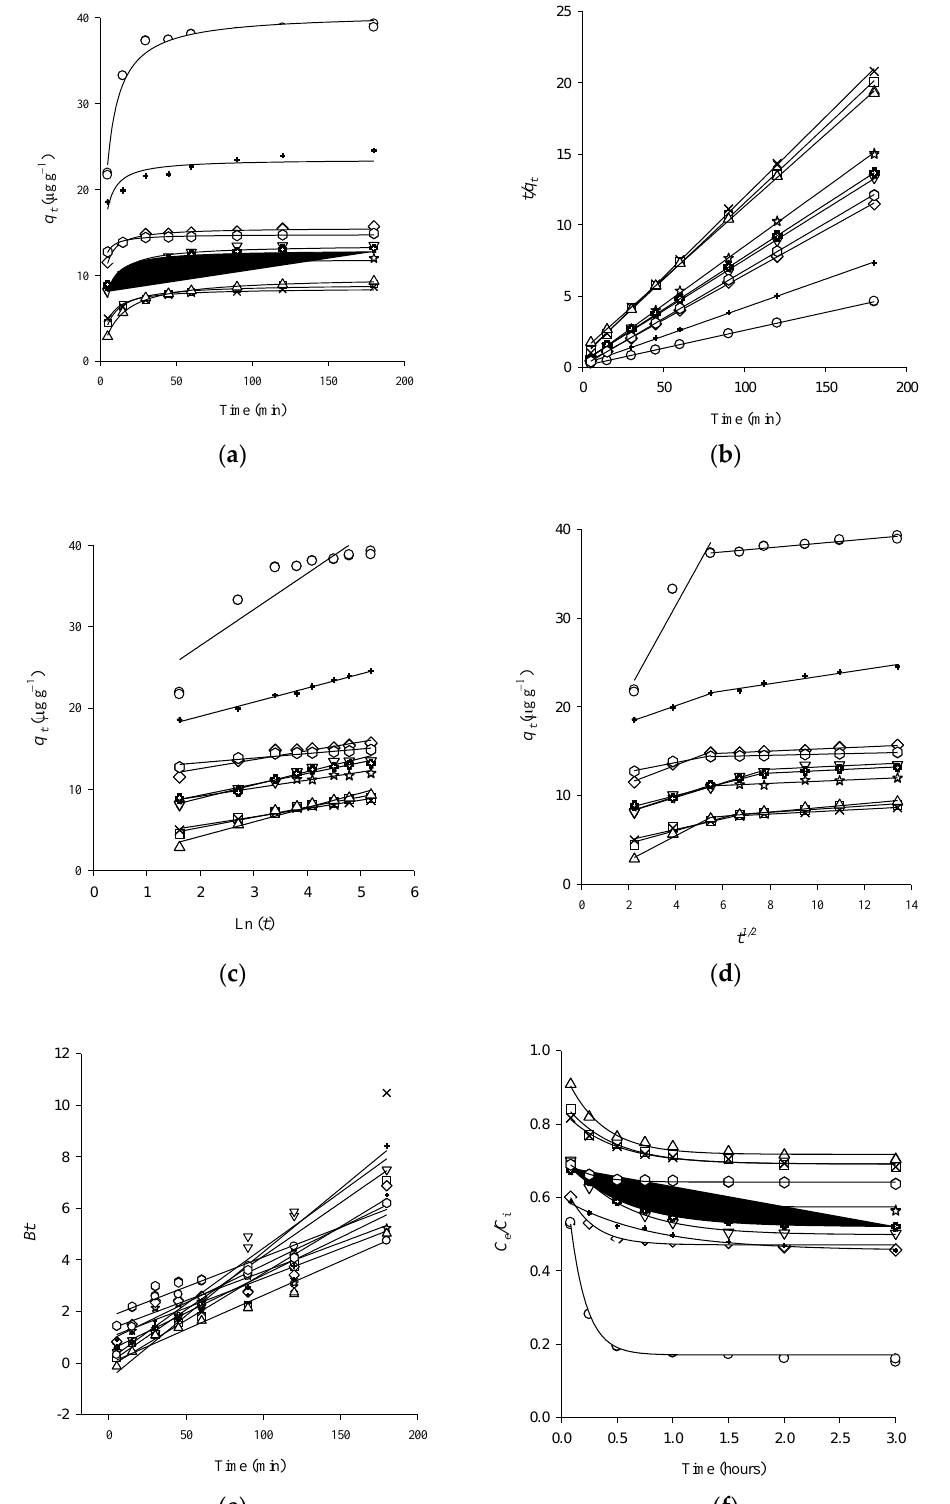
Figure 1. Plot for 2,4-D sorption on volcanic ash-derived soils: COLL (□), MET (×), FRE ( ☆ ), STB ( ◇ ), OSN ( ▽ ), DIG ( △ ), TEM ( ), RAL (+), NBR ( ○ ) and FRU ( ). ( a ) Hyperbolic; ( b ) Pseudo-second-order ( PSO ); ( c ) Elovich; ( d ) Intraparticle Diffusion ( IPD ); ( e ) Boyd, and ( f ) Two-Site Non-Equilibrium ( TSNE ) models. Symbols represent the experimental data, and lines represent the theoretical curves described by each model.